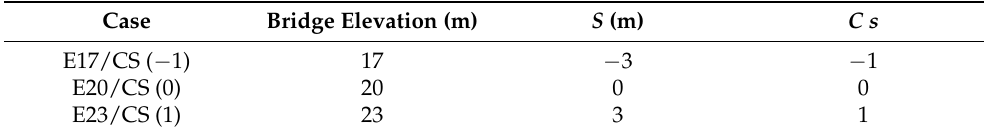
Table 5. The bridge deck elevations and corresponding coefficients.